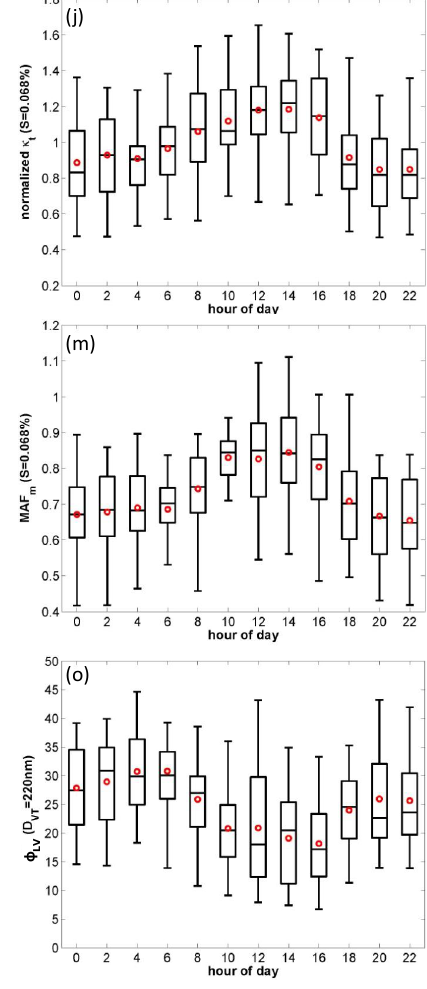
Fig. 12i–o were dominated by convective mixing during day- time leading to dilution and to a decrease of the soot